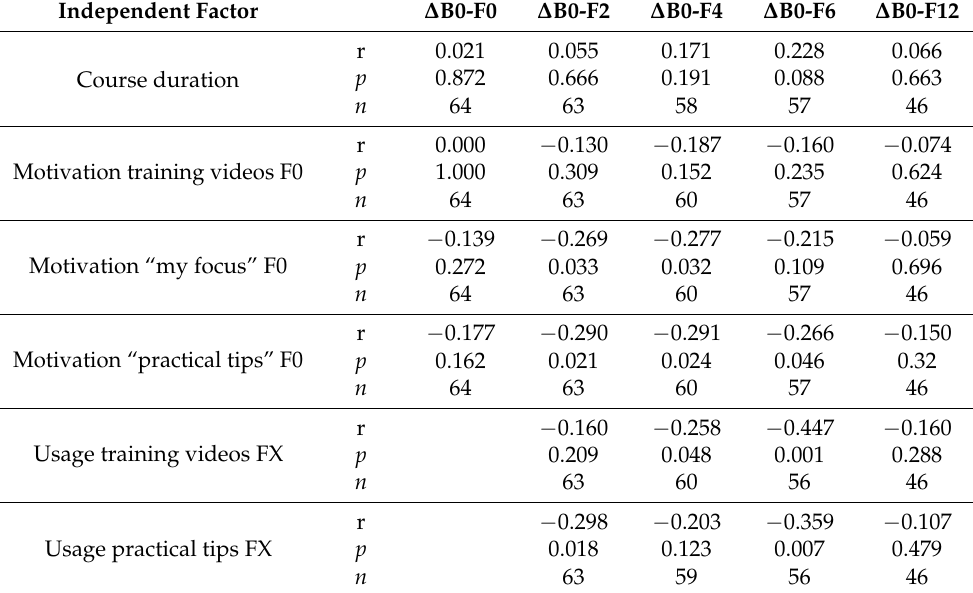
Table A9. Spearman-Rho Test for measuring correlations: Influence of different factors on the effect of the app on the BMI between B0 and the following measurement points.